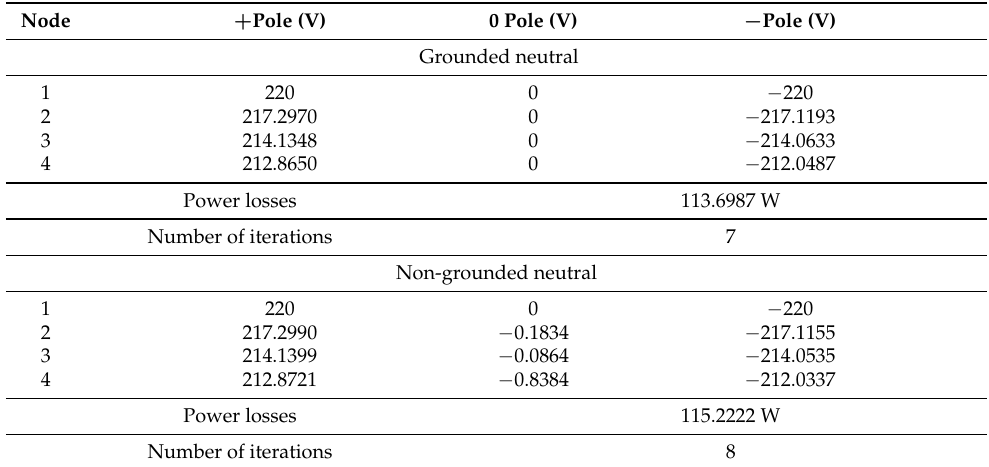
Table 5. Voltage profiles for both simulation cases with the successive approximation power flow